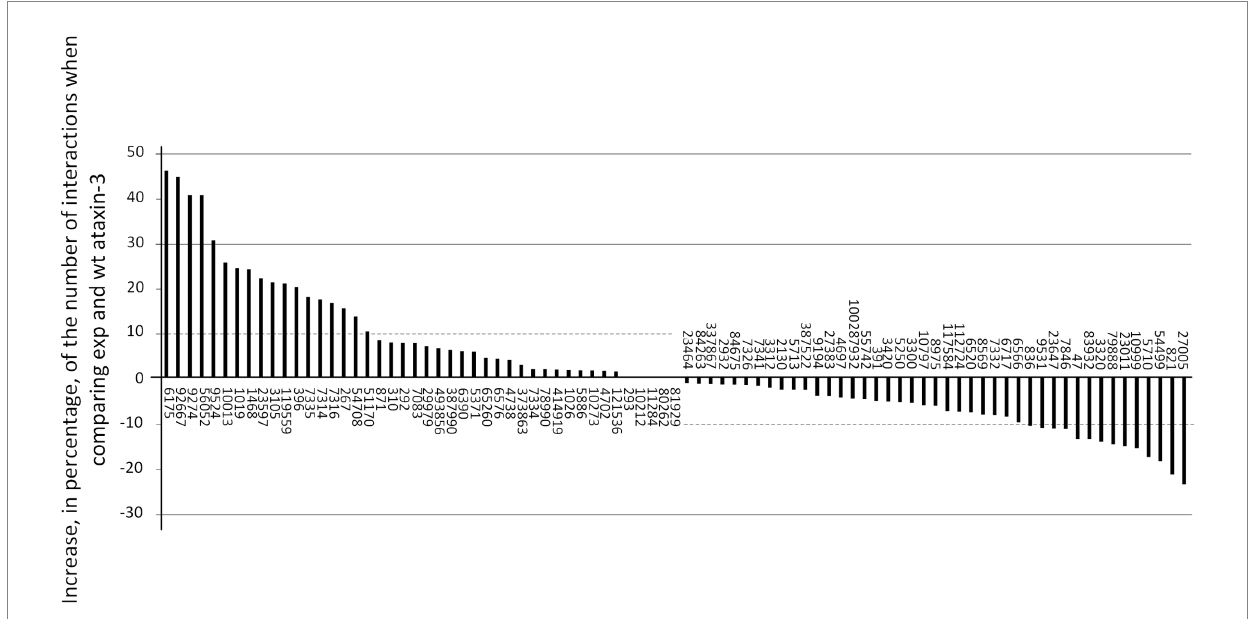
FIGURE 6 Increase, in percentage, of the number of interactions when comparing exp and wt ataxin-3 forms for 87 interactors, assigned as